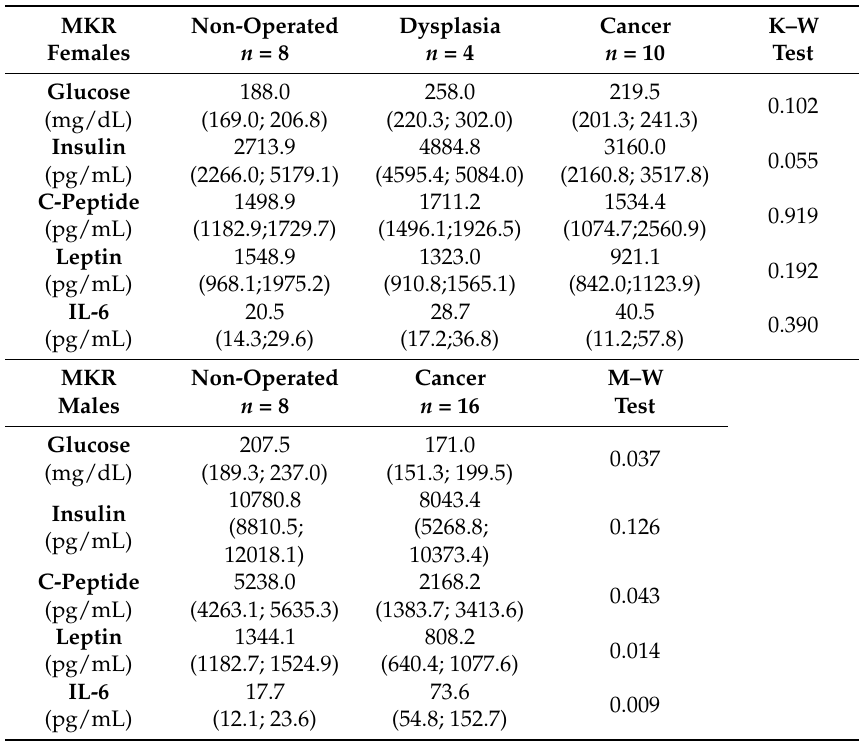
Table 4. Serum metabolic parameters in operated MKR mice. Data were expressed as Median (Q1; Q3). Data obtained in operated mice affected by dysplasia or cancer were compared to strain-, sex-, and age-matched non-operated animals (43 weeks). K–W test indicates the Kruskal-Wallis test result used for multiple comparisons among the three groups of mice. M–W test indicates Mann-Whitney U -test result used to compare data distribution between two groups of mice (No MKR males were affected by dysplastic lesions). A p -value lower than 0.05 was considered statistically